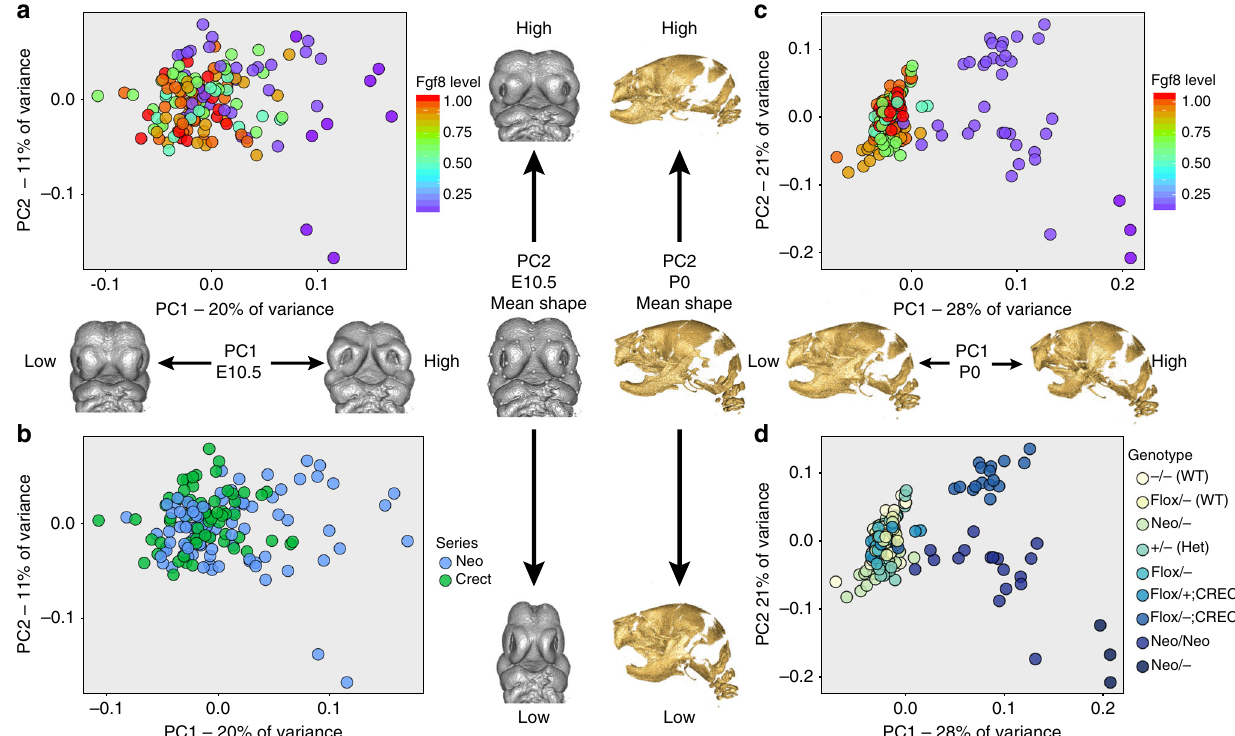
Fig. 3 Shape changes in response to decreased Fgf8 gene dosage. Principal component analysis (PCA) of shape at E10.5 ( a , b ) and P0 ( c , d ). Gray embryos (E10.5) show shape change trajectories for PC1 (horizontal) and PC2 (vertical), and the middle vertical image represents the mean shape for each time point. Gold skulls show the same shape change trajectories for the P0 data. a , c PC plots colored by Fgf8 level with warm colors representing wild-type embryos and cool colors and purples showing around 20% Fgf8 mRNA expression (mean per group by qRT-PCR). b Coloration by genotypic series, genotypes separate by allelic series, but the differences between low PC1 and low PC2 are small. The mean shape of individual genotypes is already signi fi cantly different (Procrustes permutation test, P < 0.001) by E10.5. d Coloration by genotype as used in the rest of the paper. A total of 187 neonates were analyzed and divided between groups as follows: WT (+/+) = 22, Flox/+ = 29, Neo/+ = 41, Flox/ − = 10, ± = 25, Flox/+;Crect = 21, Flox/ − ;Crect = 19, Neo/Neo = 17, and Neo/ − = 3 (w/all landmarks present). A total of 156 embryos were analyzed and divided between groups as follows: WT (+/+) = 27, Flox/+ = 15, Neo/+ = 30, Flox/ − = 13, ± = 16, Flox/+;Crect = 16, Flox/ − ;Crect = 19, Neo/Neo = 12, and Neo/ − =